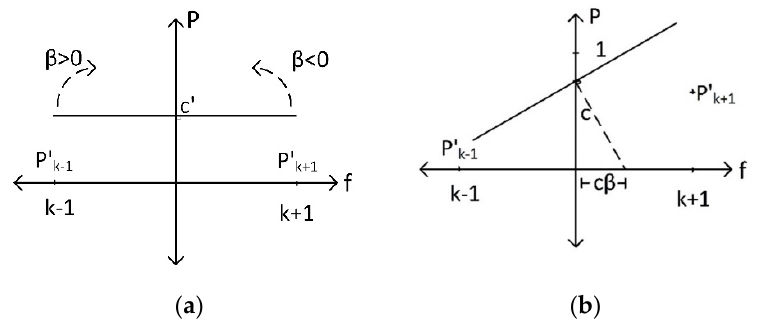
Figure 3. Calculating estimated instantaneous frequency: ( a ) when β = 0, the normal to the regression line points to the peak frequency bin; ( b ) upon changing slope of the regression line, the intersection point of the normal line on the frequency axis moves |Cβ| away.